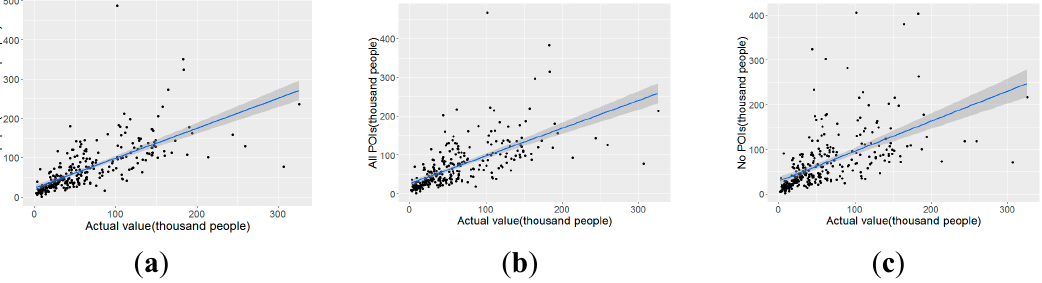
Figure 9. Scatter plots of the dasymetric model driven by PSP, all POI records and no POI. ( a ) PSP ( b )